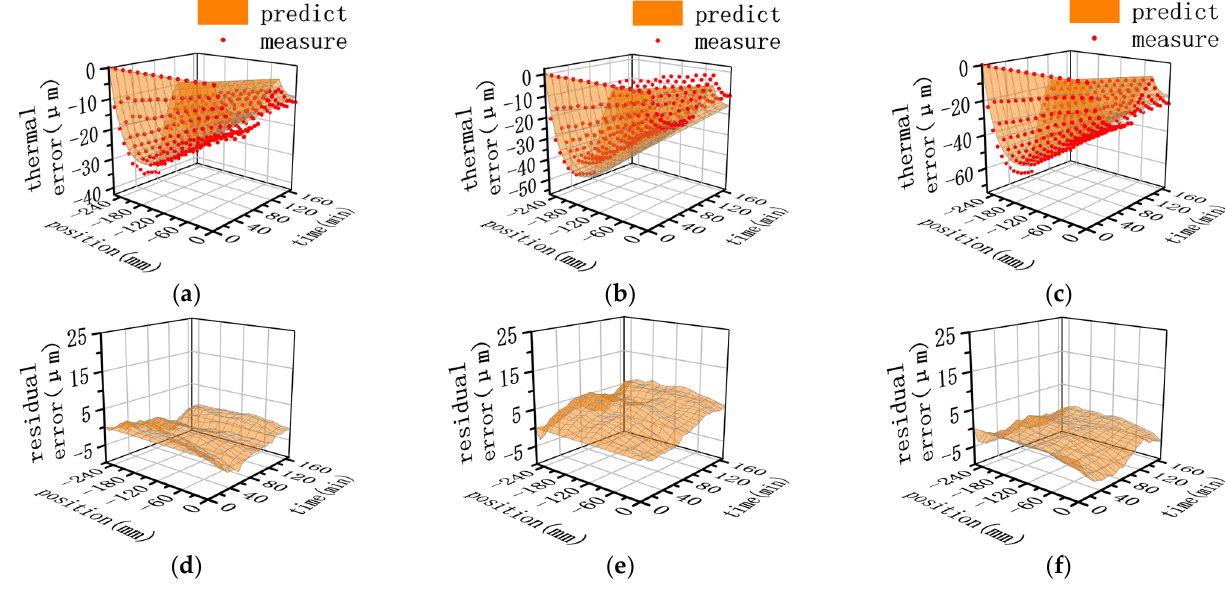
Figure 10. Y-axis error results. ( a ) Measured thermal error in Condition 1. ( b ) Measured thermal error in Condition 2. ( c ) Measured thermal error in Condition 3. ( d ) Residual error in Condition 1. ( e ) Residual error in Condition 2. ( f ) Residual error in Condition 3.